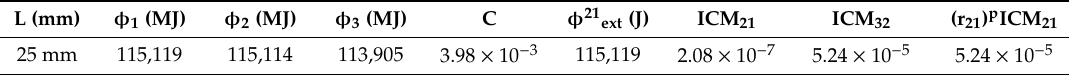
Table 5. Data of the mesh convergence study for conduction energy gain by the thermal insulation during the kiln heating process